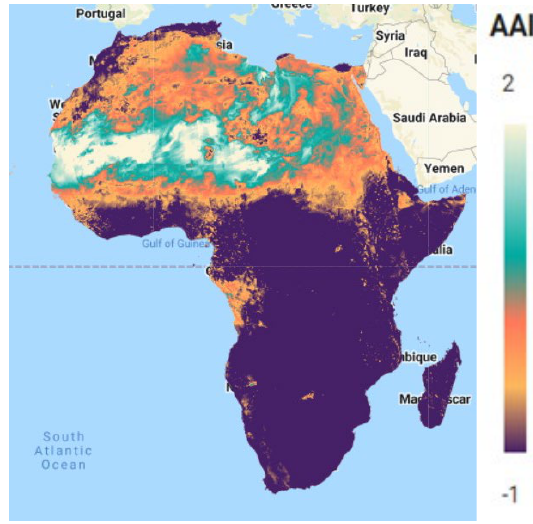
Fig. 5. Aerosol movement from the 10 th – 12 th of June 2020 The western part of Africa with countries such as Western Sahara, Mauritania, and Mali were not left out on the impact of the Godzilla dust plume. As seen in Fig 6, the west shows a higher absorbing aerosol index of 2. Confirming a study made by Warren (2020), the first traces of the dust reached the Caribbean by 20 th